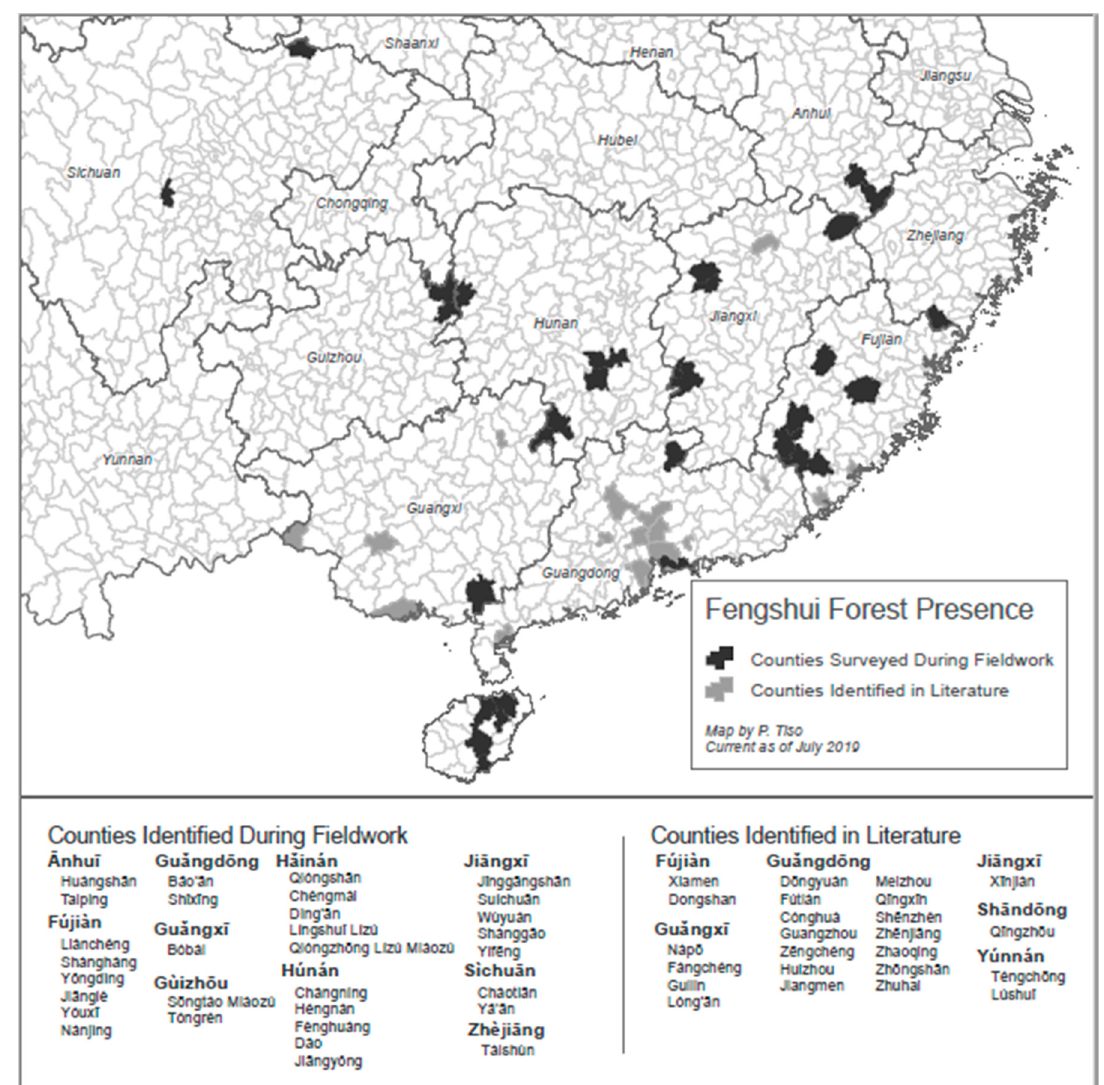
Figure 2. Map of counties where fengshui forest research was conducted and where fengshui forest research has been conducted by Chinese botanists (as seen in the literature).